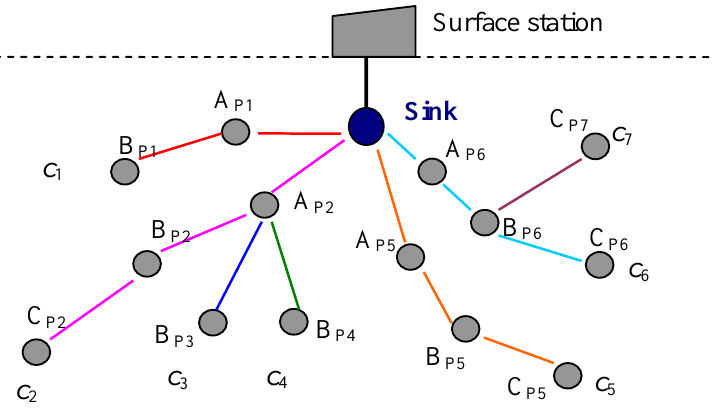
Figure 7. Spreading sequences assignment for